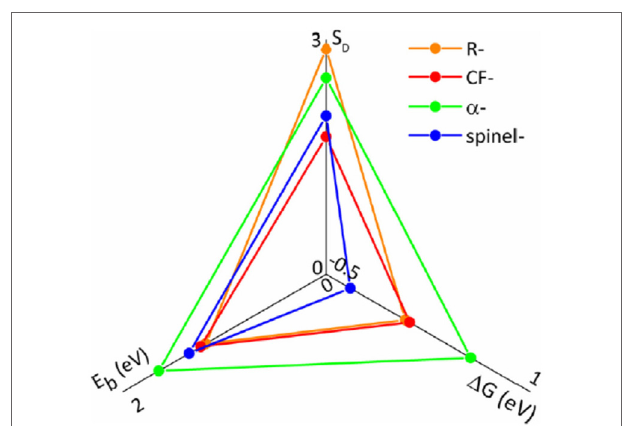
FigURe 6 | Triangular radar graph to quantitatively assess the free energy change ( Δ G), deformation score (S D ), and the diffusion barrier (E b ) for the magnesiation of MnO 2 polymorphs. Reprinted with permission from Ling et al. (2016). Copyright 2016 American Chemical